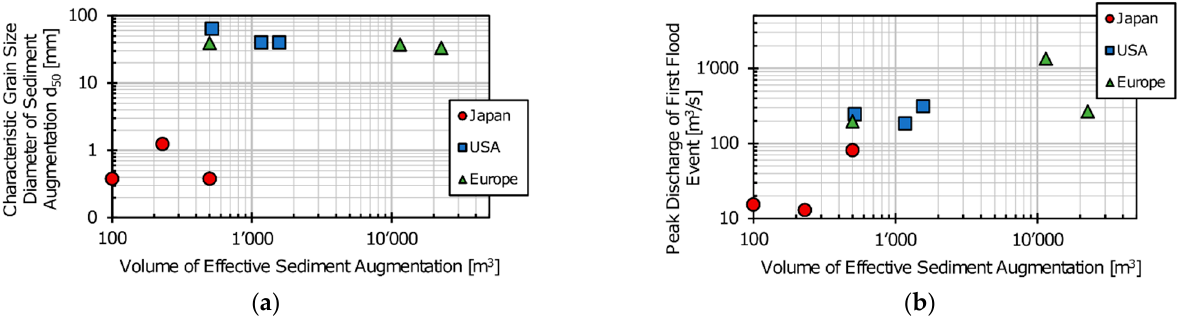
Figure 1. Data concerning single sediment augmentation measures from three regions over the last two decades: ( a ) grain size diameter and ( b ) peak discharge against the volume of effective sediment augmentation. For data and sources, see Table A1.